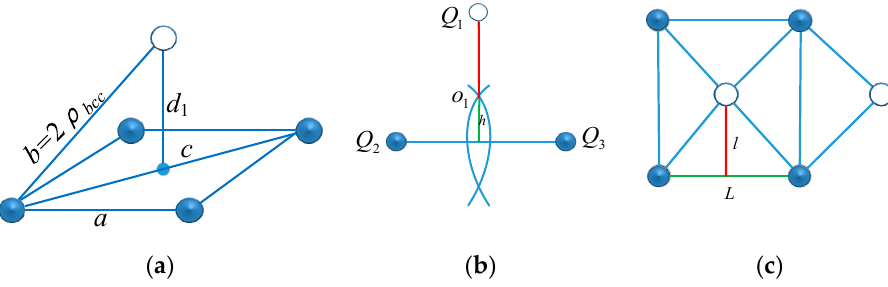
Figure 2. ( a ) Front view, ( b ) Common coverage area and ( c ) Vertical view.